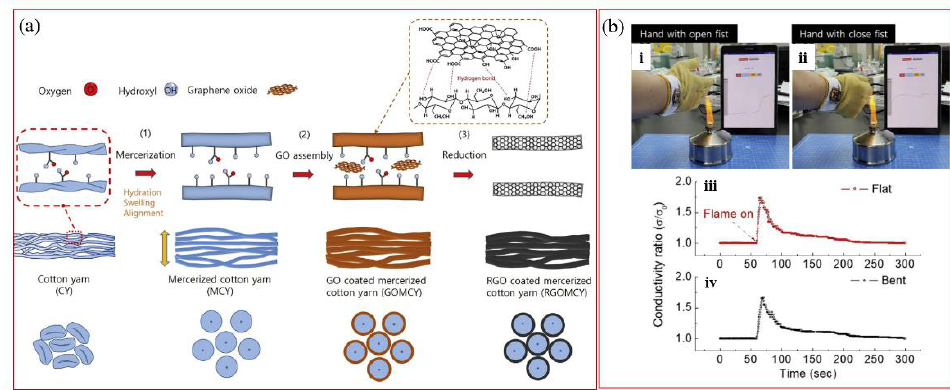
Figure 3. ( a ) Schematic representation of fabrication process and mechanism of rGO-coated mercerized cotton yarn. ( b ) Photographs of the smart glove for fire/flame monitoring for the flat and bent yarn. Reprinted with permission from Reference [30]. Copyright (2019) Elsevier.